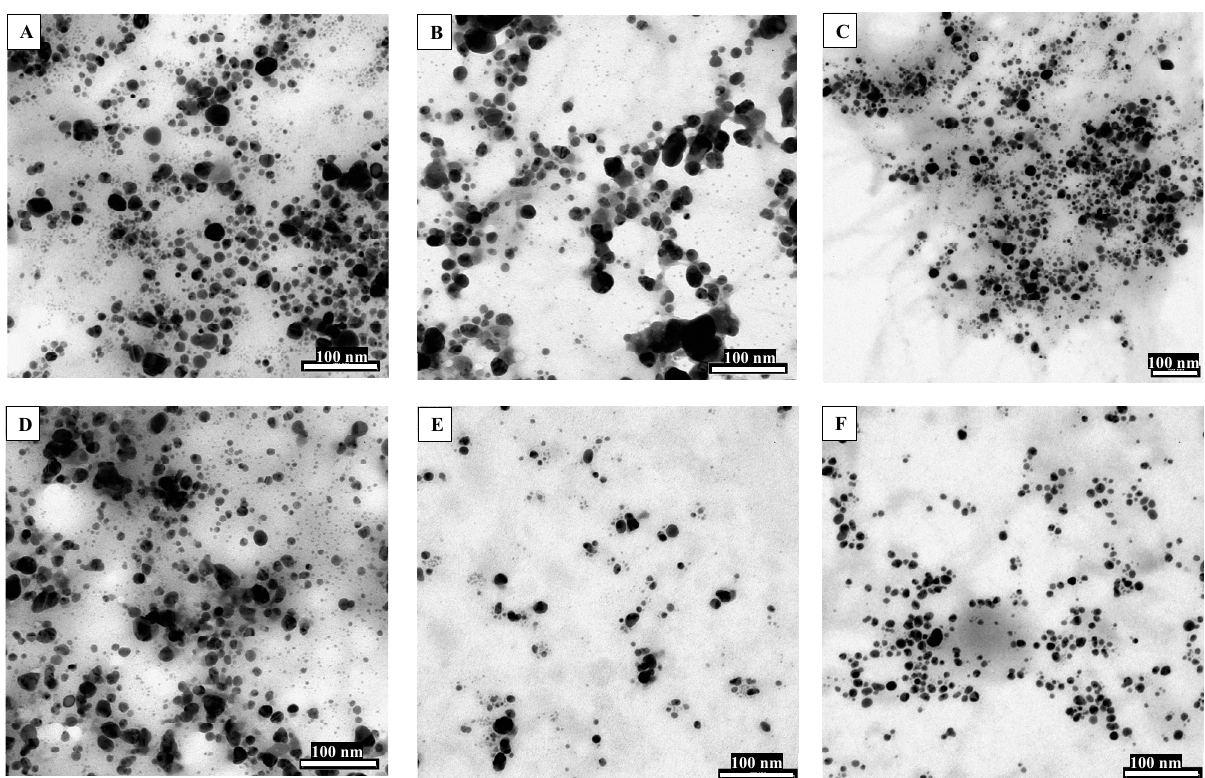
Figure 2. TEM micrographs presenting sphere-shaped AgNPs synthesized by various Fusarium species. ( A ) F. graminearum; ( B ) F. solani; ( C ) F. oxysporum; ( D ) F. culmorum; ( E ) F. scirpi; ( F ) F. tricinctum . (Reproduced with permission from Gaikwad et al. [30]).